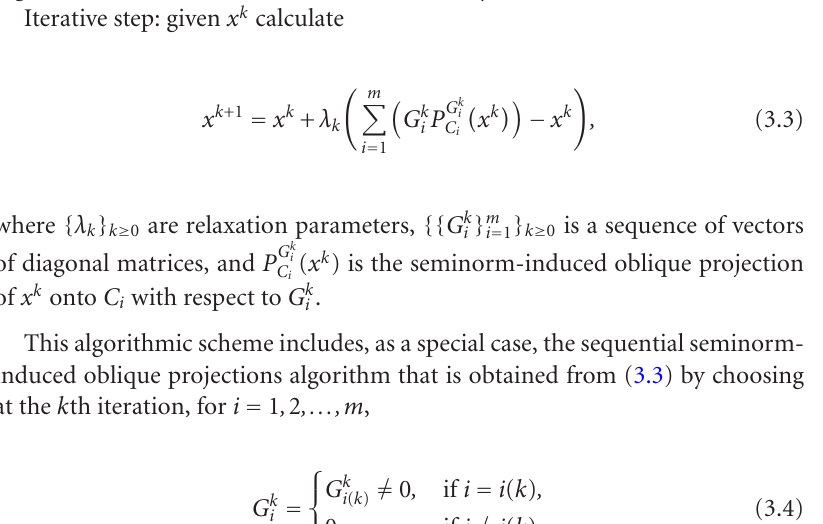
Algorithm 3.2. Initialization: x 0 ∈ R n is